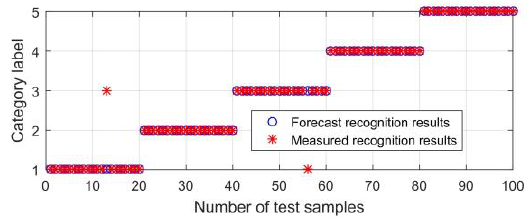
Figure 15. The fault recognition results of the proposed